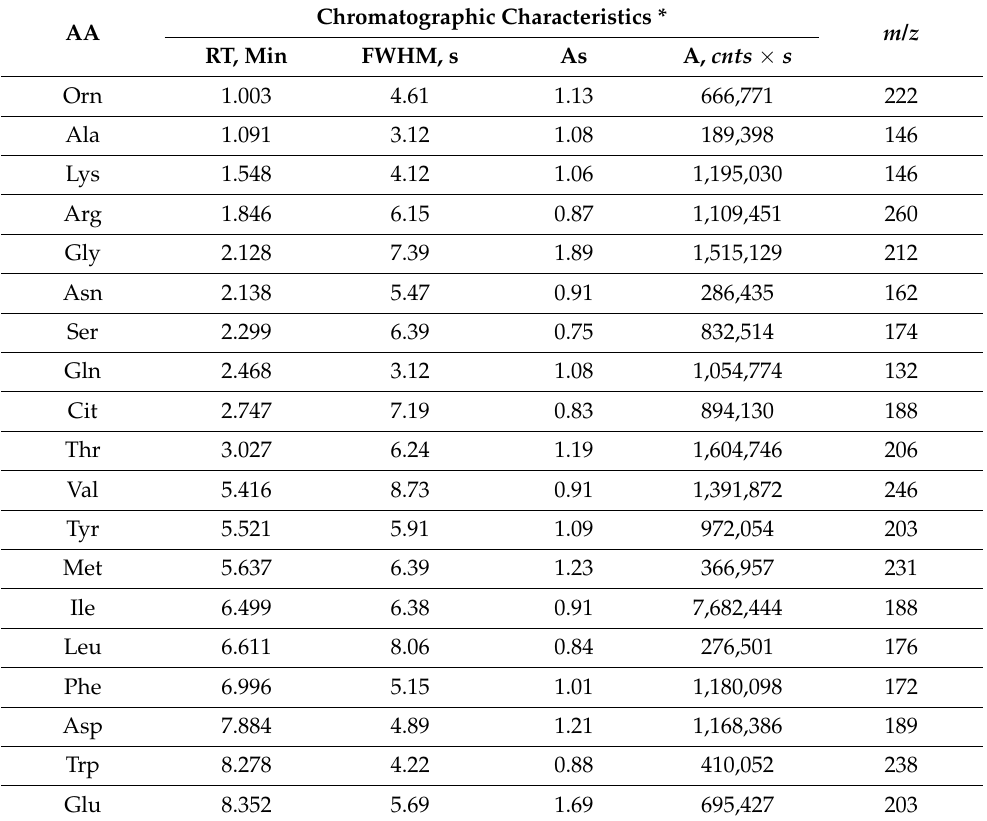
Table 4. Chromatographic characteristics of derivatized amino acids obtained using time-of-flight quadrupole